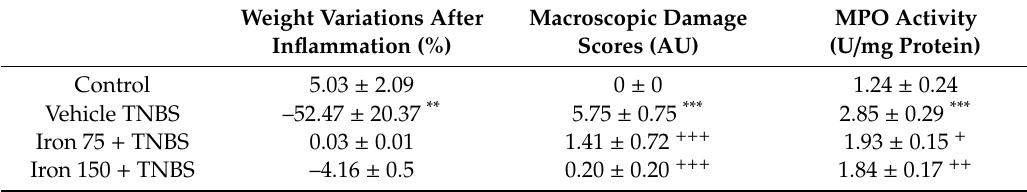
Table 2. The incidence of iron supplementation (75 and 150 mg/kg/day po ) on weight variations, macroscopic lesions and myeloperoxidase activity (MPO) activity in trinitrobenzene sulfonic acid (TNBS)-treated mice. Data are expressed as mean ± SEM.